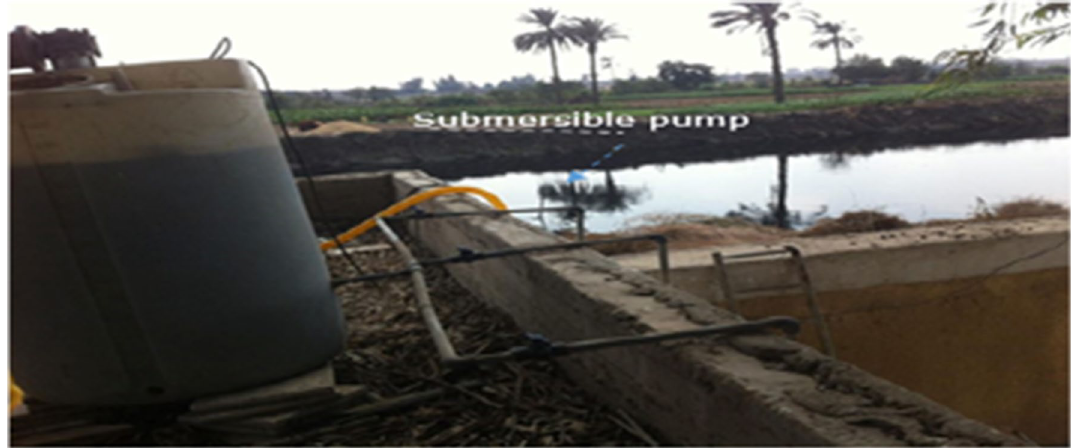
Fig. 2 Photograph of the filtration model